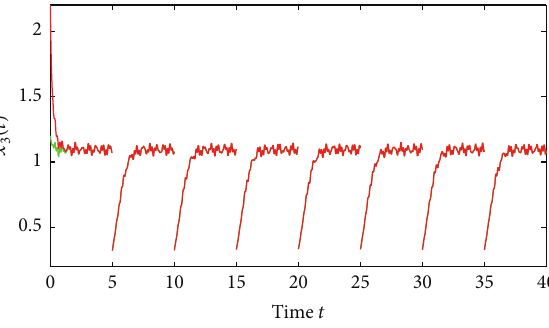
Figure 2: State variable 𝑥 2 of Example 1.